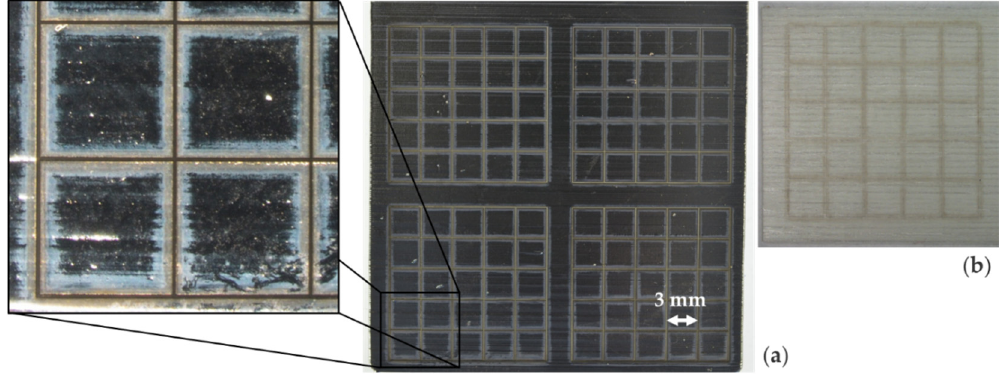
Figure 6. Example of a test specimen (physical vapor desposition coated, electroplated and structured; cut width 50 µm) for temperature change testing: ( a ) Photo of the specimen and detail view via microscopy; ( b ) Tape with adhering laser ablation residue after the tape-test.